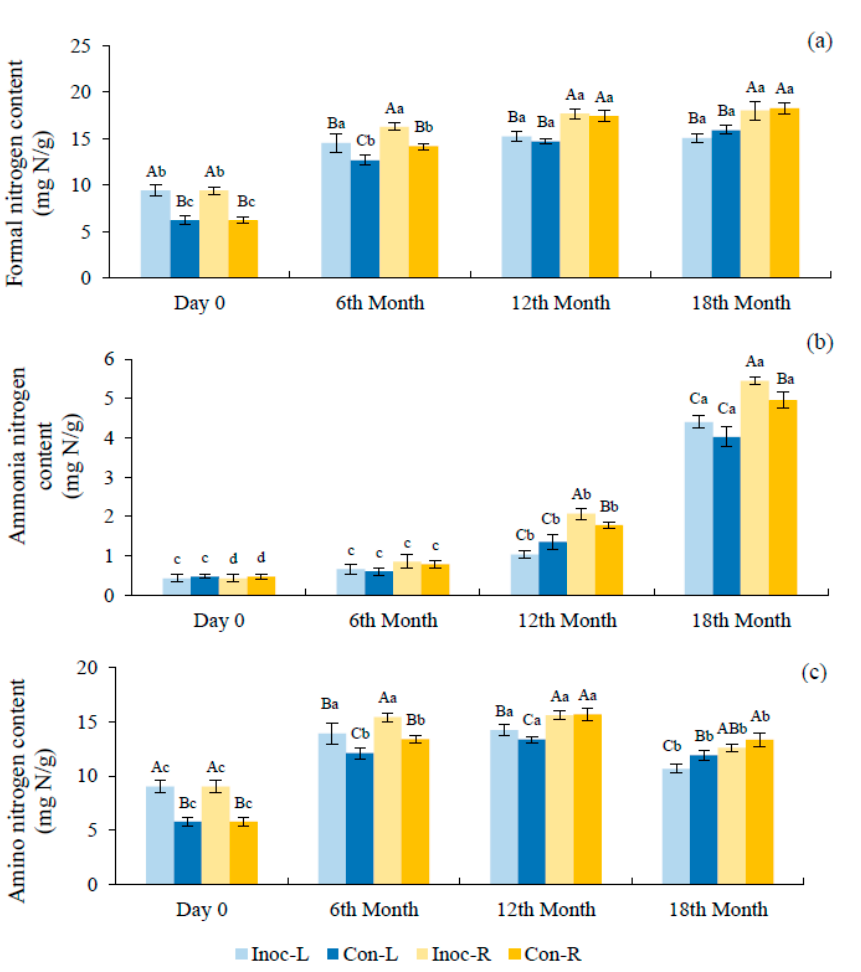
Figure 2. Formal nitrogen ( a ), ammonia nitrogen ( b ), and amino nitrogen ( c ) contents of shrimp paste with/without B. subtilis K-C3 inoculation during storage for 18 months at low (4 °C) and room (28 °C) temperature. Different lowercase letters indicate significant differences (p < 0.05) as affected by storage time. Different uppercase letters indicate significant differences (p < 0.05) between samples with the same storage time.